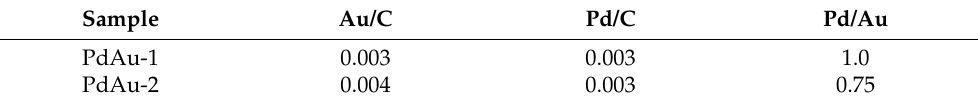
Figure 1. STM images ( upper panels ) and histograms of particle sizes ( bottom panels ) for the prepared model catalysts: PdAu-1 ( left ) and PdAu-2 ( right ). Tunneling parameters: 0.51 nA, − 600 mV (PdAu-1); 0.56 nA, +1500 mV (PdAu-2). Table 1. Element ratios calculated from the XPS data measured in UHV after annealing at 400 °C (photoelectron kinetic energy of 300 eV corresponding to the surface localization).